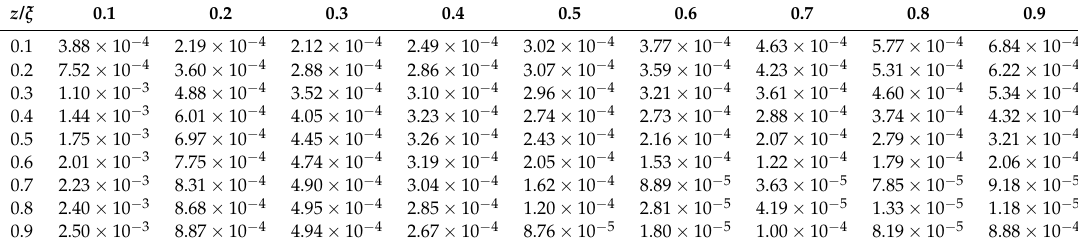
Table 6. Absolute error values of Example 2 for Burgers’ equation with α = 0.8.